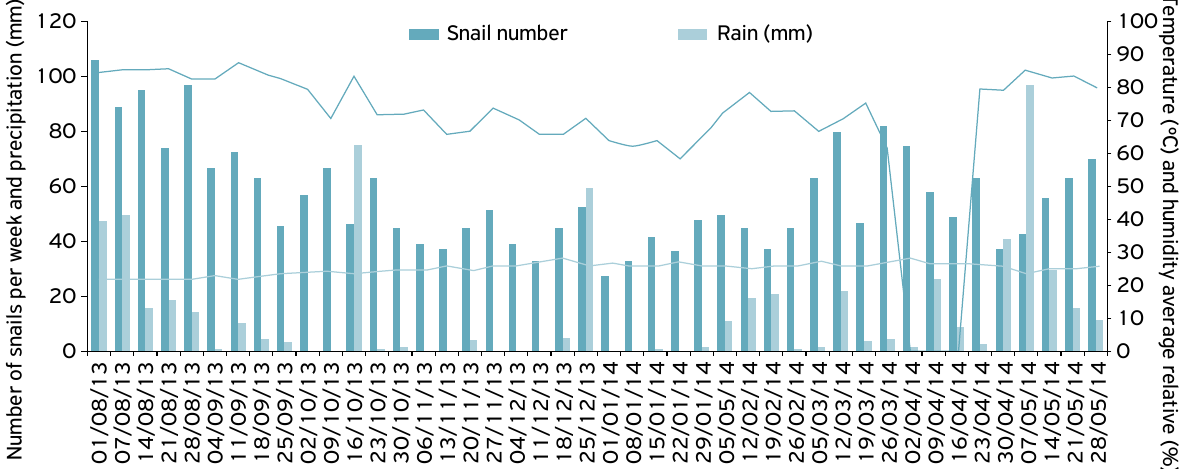
Figure 4. Weekly variation of adult of Achatina fulica collected from August 2013 to May 2014 in lettuce area ( Lactuca sativa L.), in the location of Furnas, Arapiraca, Alagoas,